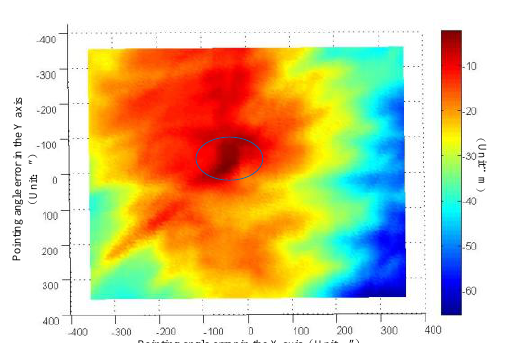
Figure 2. Elevation error distribution of laser foot prints with different pointing error